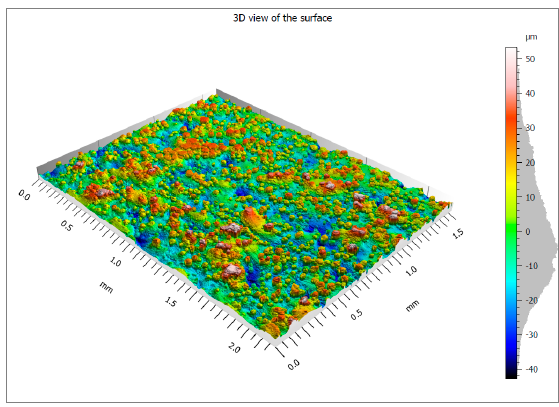
Figure 5. 3D surface roughness map for as-printed sample.